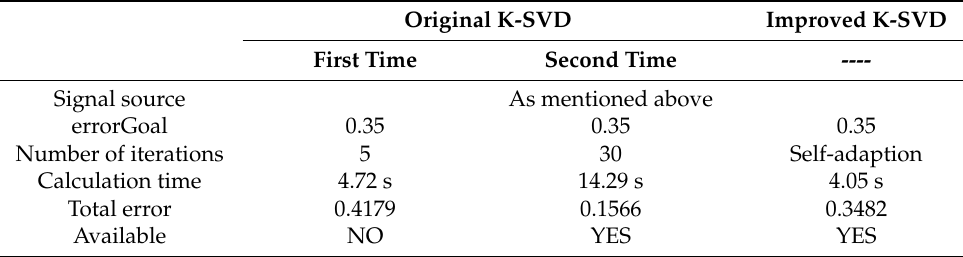
Table 2. Comparison of the level of performance between the original K-SVD and the improved K- SVD.